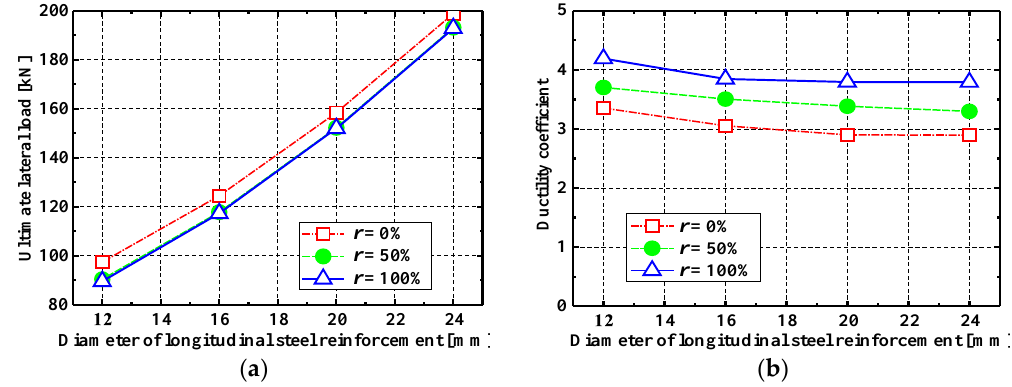
Figure 13. Effect of steel ratio on the seismic performance of RRC columns. ( a ) Capacity. ( b ) Ductility.